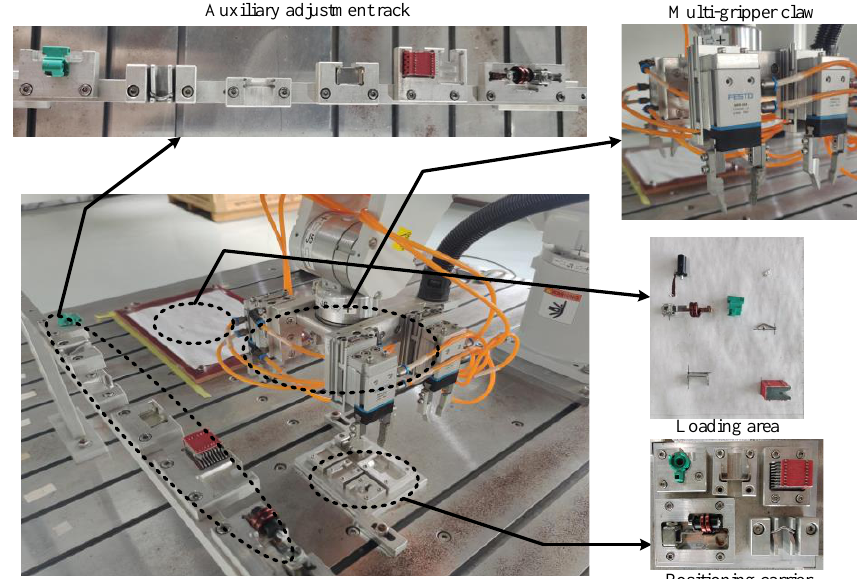
Figure 15. Experimental platform of posture adjustment.